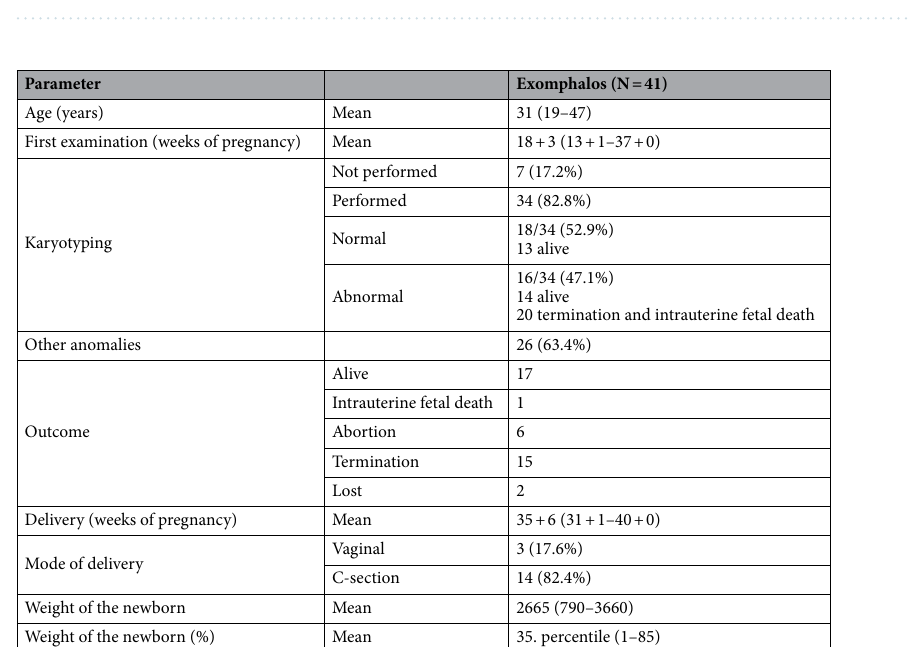
Figure 3. Measurement of apED and EDmax.